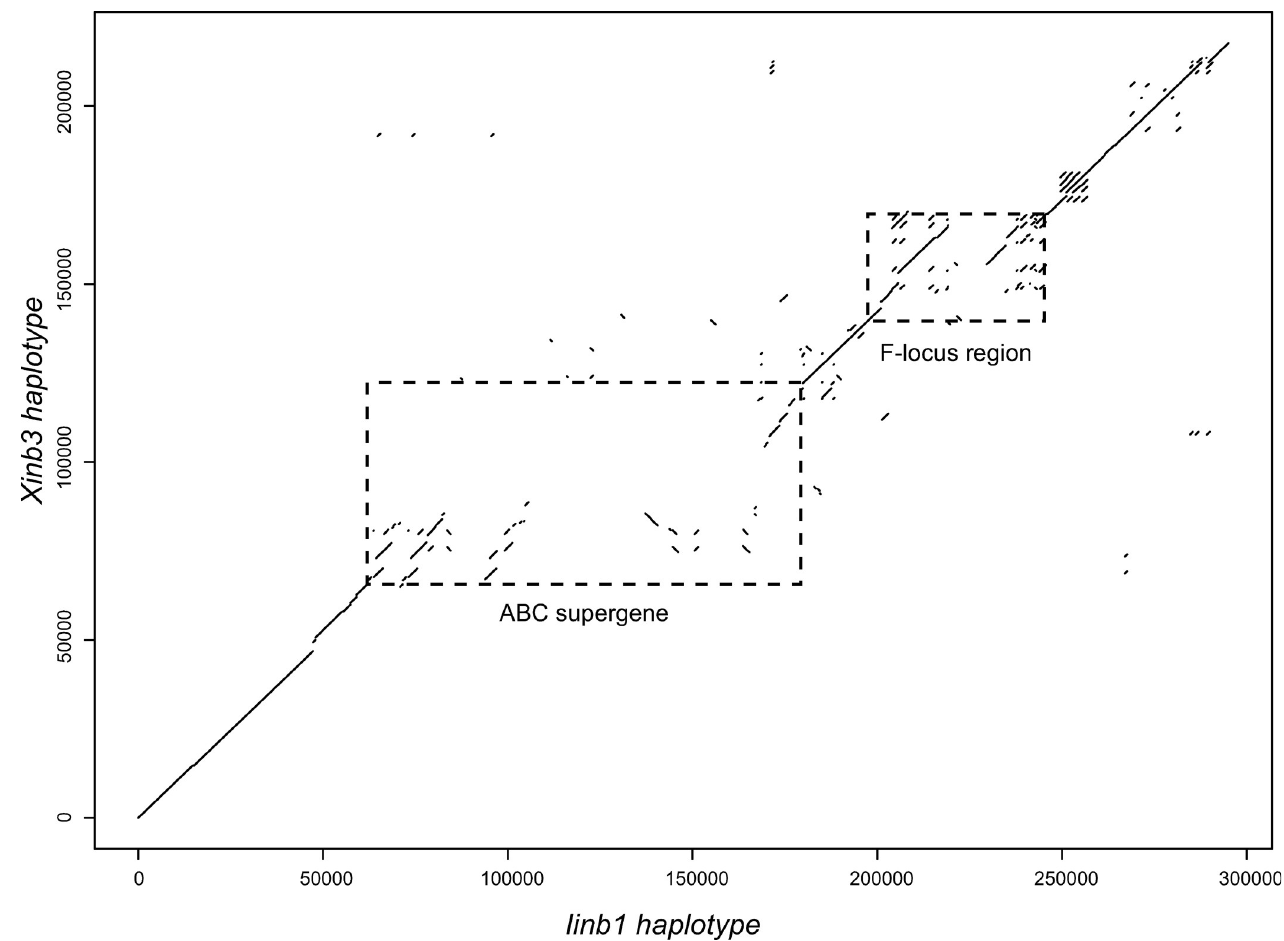
Fig 2. Compared alignments at ABC supergene and F-locus region. Dot plots of aligned DNA sequences show regions of homology between QTL parent clones Xinb3 and Iinb1. The depicted alignment includes the ABC region (which contains the ABC supergene) and the neighboring F-locus region, plus 50 kb beyond the F-locus region to aid visual comparison. Axes indicate base-pair position along each respective haplotype. Dashed boxes denote the ABC supergene and F-locus region. This figure has been modified from a previously published figure (Fig 3 in [16]) to specifically compare the location and alignment structure of the ABC supergene and F-locus